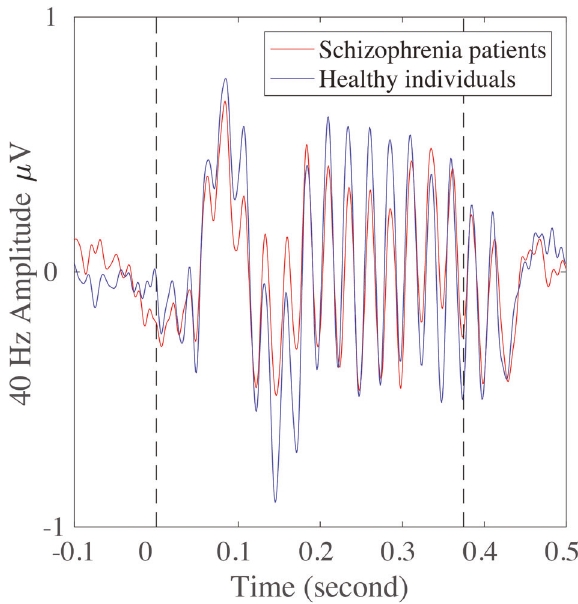
Fig. 1 Grand averages of 40 Hz auditory steady-state response (ASSR). The ASSRs for both schizophrenia patients and healthy individuals are in red and blue,